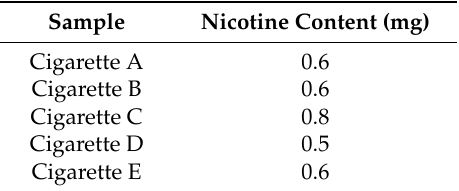
Table 1. Characteristics of the selected tobacco